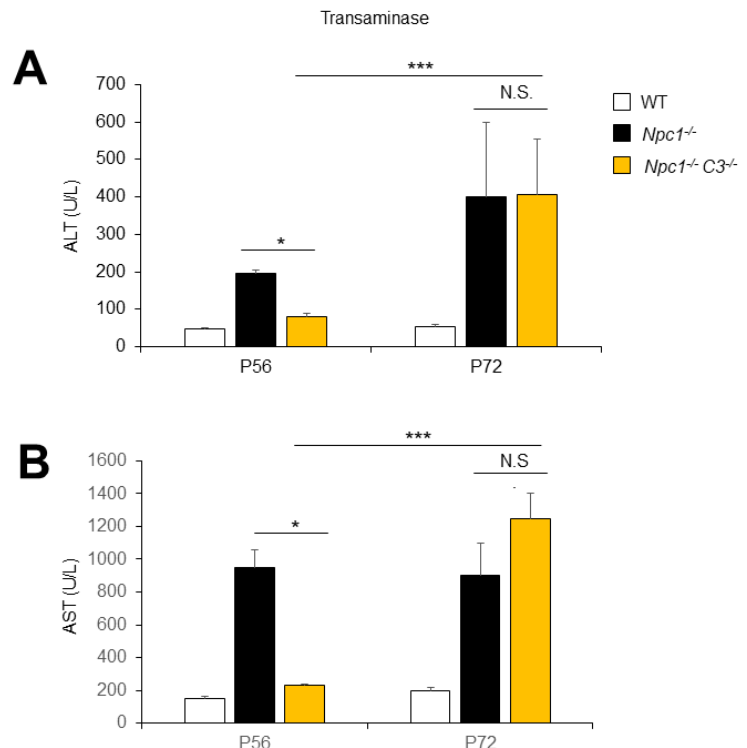
Figure 4. C3 ablation prevented NPC liver damage at P56 but not at P72. ( A ) Alanine and ( B ) aspartate aminotransferases (ALT and AST, respectively) were measured in P56 and P72 animals of the indicated genotypes. Data are presented as means ± SD. ( n = 5 animals / group, two-way ANOVA and Tukey’s multiple comparison post-test). * p < 0.01, *** p < 0.001 compared to the Npc1 −/− group.